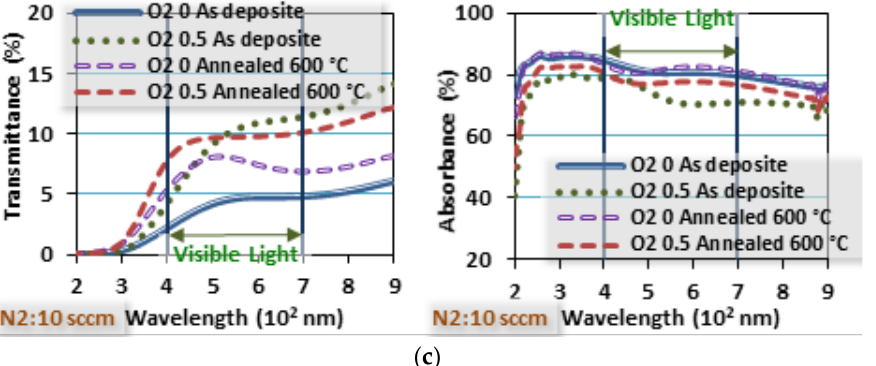
Figure 7. UV-Visible-NIR spectra of as-deposited and annealed films at 600 °C for different oxy- gen/nitrogen flow rates. (a) O 2 /N 2 = 0.15/3 sccm, (b) O 2 /N 2 = 0.25/5 sccm, and (c) O 2 /N 2 = 0.5/10 sccm.